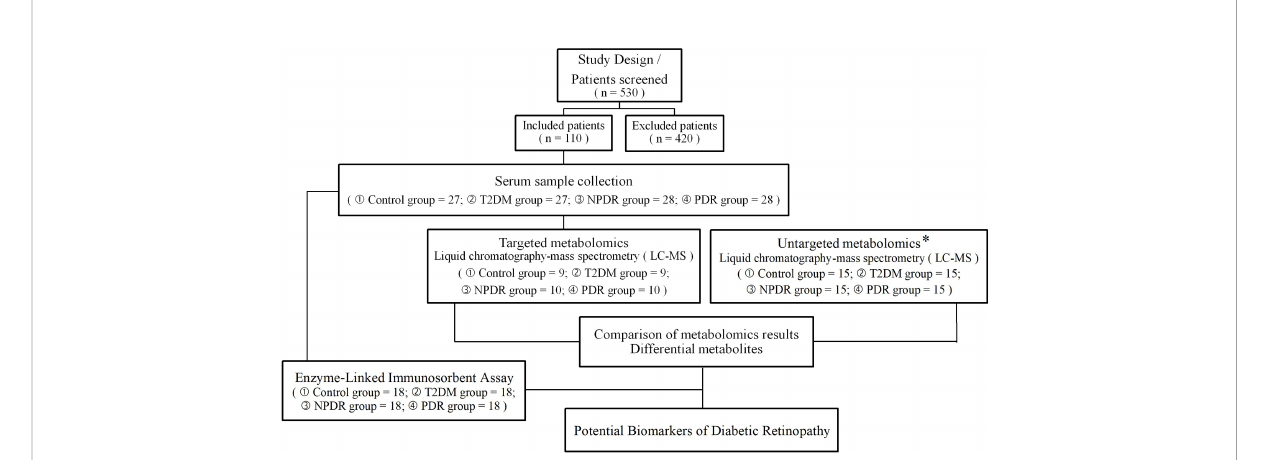
FIGURE 1 An overview of the metabolomics analysis work fl ow, and the inclusion and exclusion fl owchart of the case-control study. * The sample collection and testing in untargeted metabolomics were conducted in our previous study. T2DM, type 2 diabetes mellitus; DR, diabetic retinopathy; NPDR, non-proliferative diabetic retinopathy; PDR, proliferative diabetic